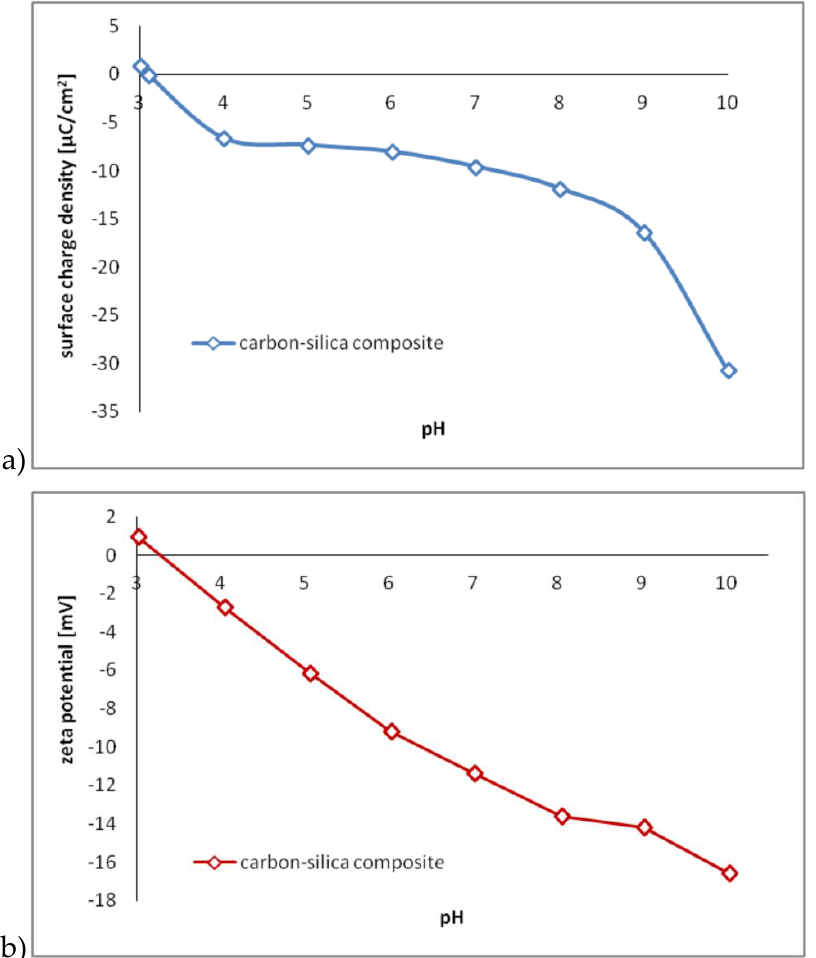
Figure 3. Surface charge density ( a ) and zeta potential ( b ) of the carbon–silica composite as a function of pH value.